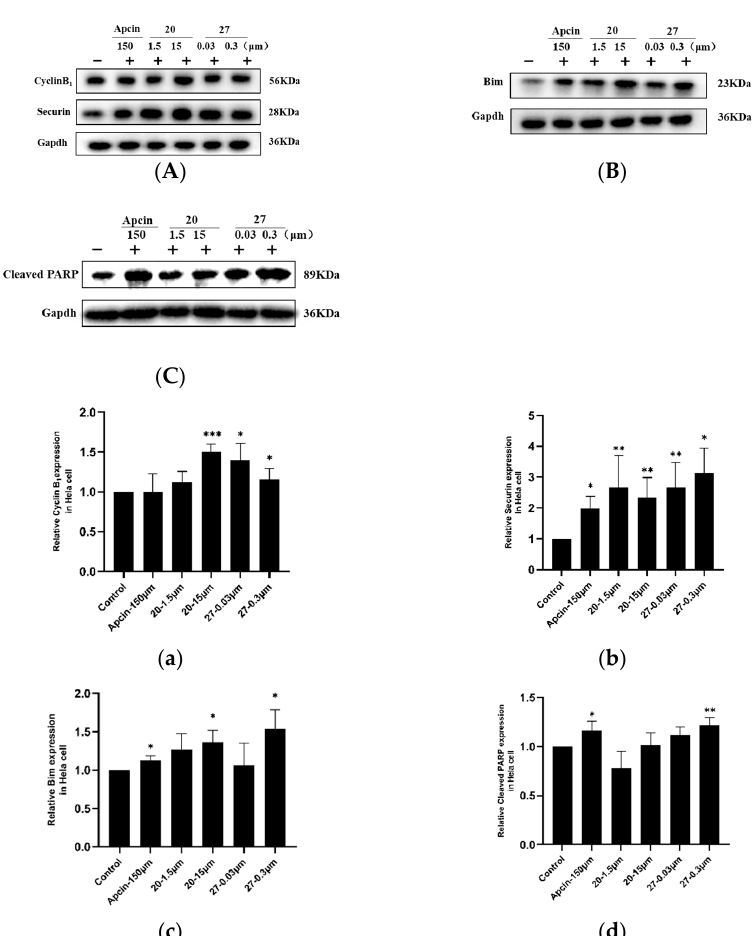
Figure 4. ( A ) Protein levels of cyclin B1 and securin were measured by Western blot. ( B ) Protein levels of Bim were measured by Western blot. ( C ) Protein levels of cleaved PARP were measured by Western blot. The results show that the compounds had an effect on the levels of Cdc20 substrates. ( a – d ) Quantitative results of ( A – C ) compared to control. Statistical significance was calculated by two-tailed unpaired t test (* P < 0.05, ** P < 0.01, *** P < 0.001, ****P < 0.0001) . It is reported that Cdc20 protein is overexpressed in various cancer-cell lines. We selected four cells lines, including Mda-mb-231, Hepg2, Mcf-7, and Hela, to investigate the Cdc20 levels and detect the expression of Cdc20 (Figure 1). The results show that the level of Cdc20 protein in Hela cells was relatively high, and was selected as the cell line for further experiments. Similarly, neither compound 20 nor compound 27 had any effect on the level of Cdc20 protein in Hela cells, as shown in Figure 4, indicating that the com- pounds did not act by regulating the translational and post-translational modification of Cdc20, consistent with the mechanism of action of a Cdc20-specific inhibitor. Cyclin B1, securin, and Bim are the key specific downstream substrates of Cdc20, which are related to cell cycle and apoptosis. Cyclin B1 is mainly expressed in the G2/M